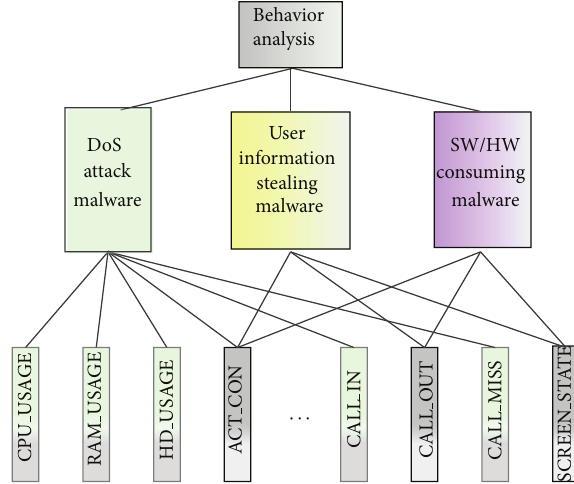
Figure 4: Hierarchical layers for the remarked